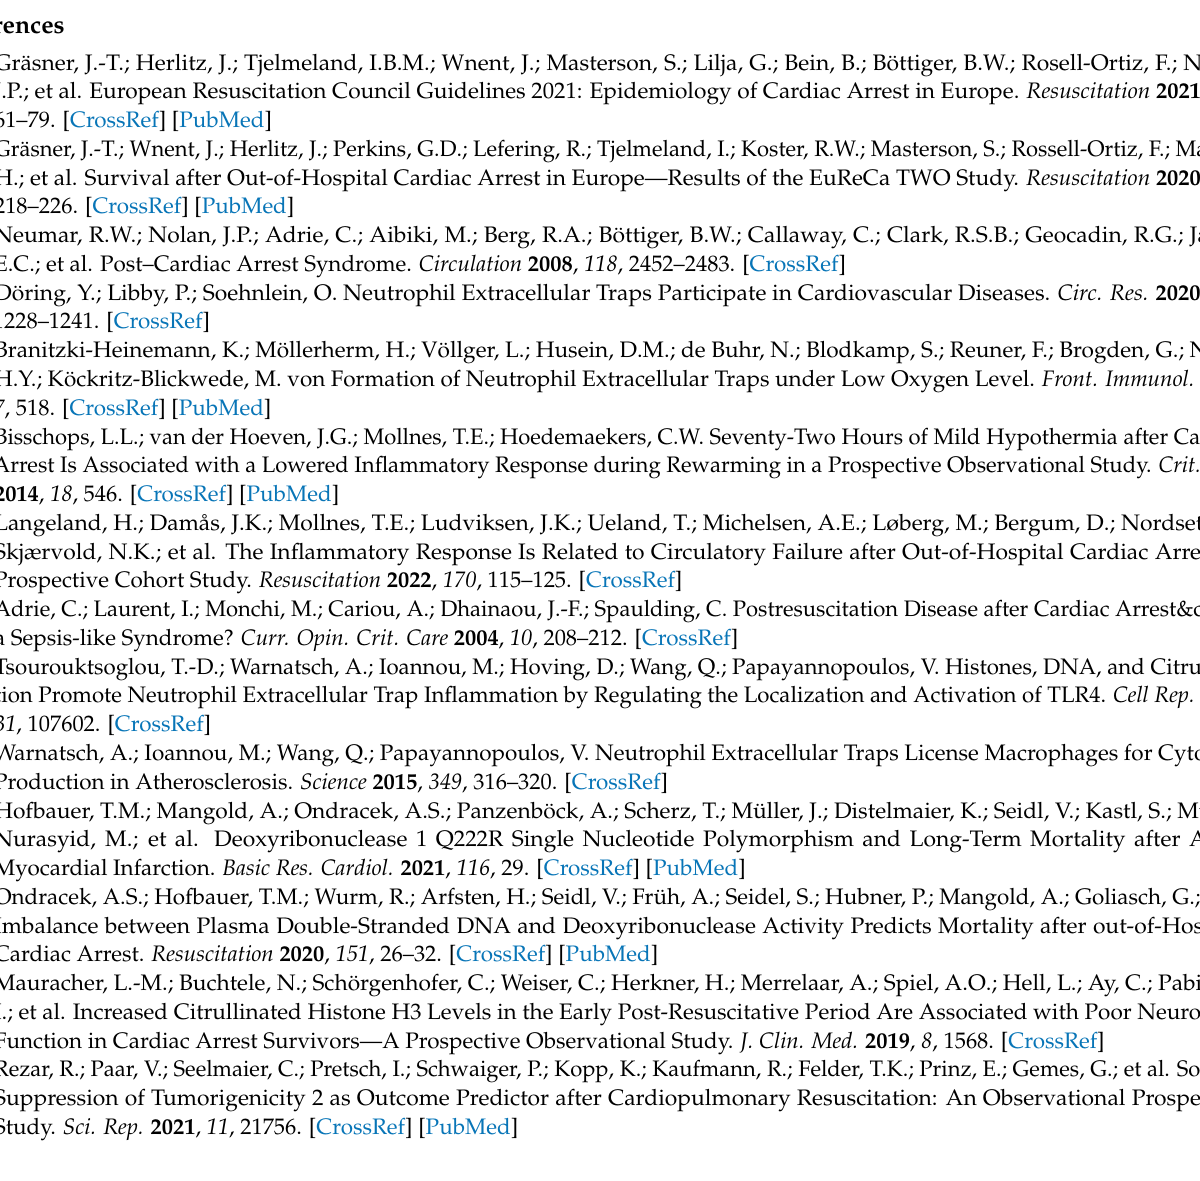
Figure A3. Age distribution. Abbreviations: CA: cardiac arrest.